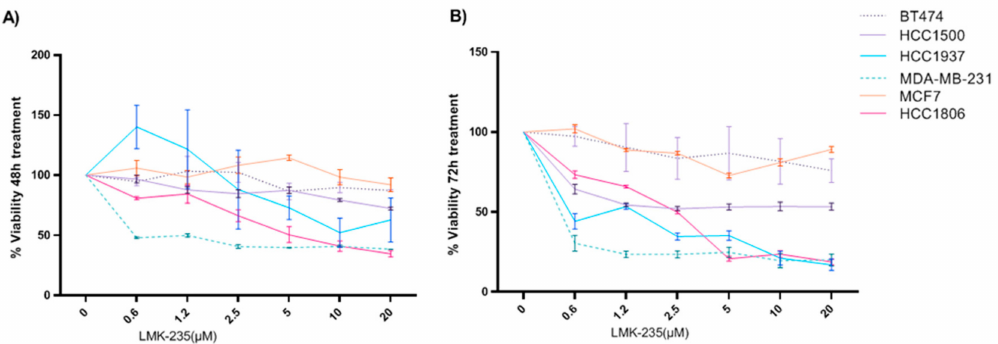
Figure 3. E ff ects of LMK-235 treatments in BC cell proliferation. Cell proliferation was determined by MTT assay for HCC1500 and HCC1937 ( < 35 years old) and MDA-MB-231, MCF-7, HCC1806, and BT-474 ( > 45 years old) cell lines that were treated with LMK-235 (0 to 20 µ M) for 48 hours ( A ), 72 h ( B ). Points indicate the mean of at least three independent experiments and the standard